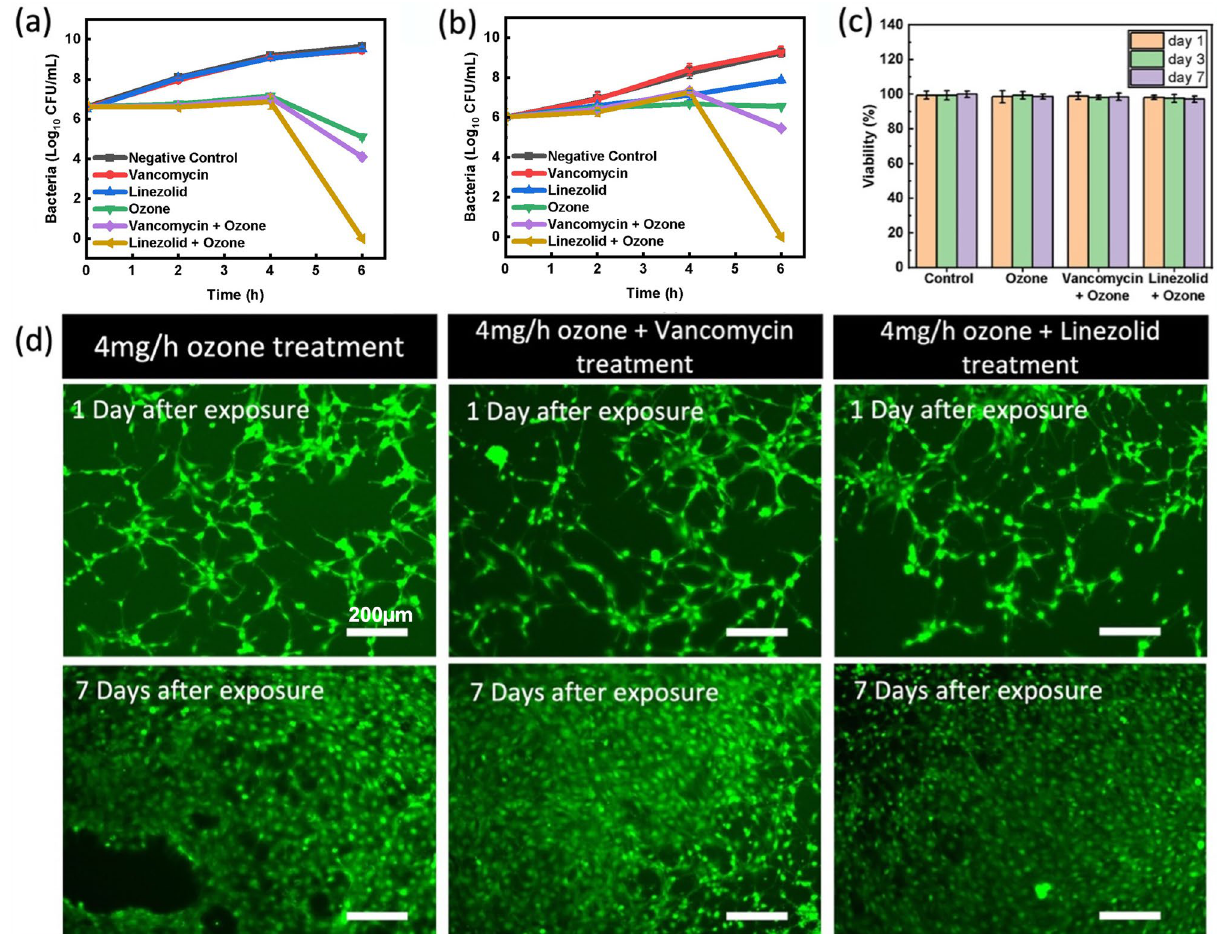
Figure 7. Antibacterial efficacy against bacteria cultures in TSB media and cell viability results of adjunct ozone and antibiotic therapy test in vitro at 37 °C. ( a ) Results for ozone + linezolid and ozone + vancomycin adjunct therapy on P. aeruginosa . ( b ) Antibacterial results of ozone + linezolid and ozone + vancomycin adjunct therapy on E. coli. Ozone was applied at 4 mg/h for 6 h. Linezolid and vancomycin were applied in solution at 200 μg/ mL. ( c ) Viability of human fibroblast cells exposed to 6 h of ozone, ozone + vancomycin, and ozone + linezolid treatment measured 1 day, 3 days and 7 days after treatment ended. ( d ) Live/Dead staining of human fibroblasts 1 day and 7 days after treatment ended. Error bars denote standard